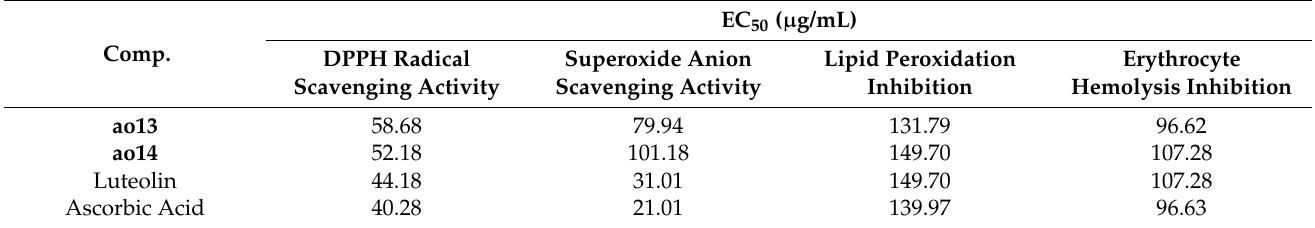
Table 60. Antioxidant activity of the synthesized compounds (ao13-ao14 ).